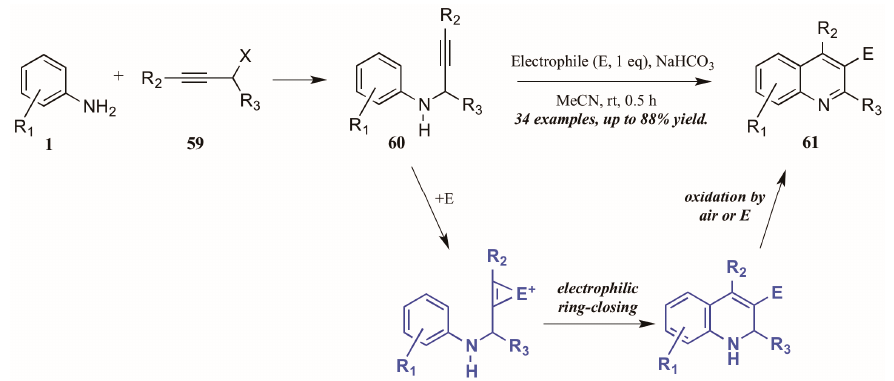
Figure 28. Quinoline synthesis via electrophilic cyclization of anilines and alkynes.